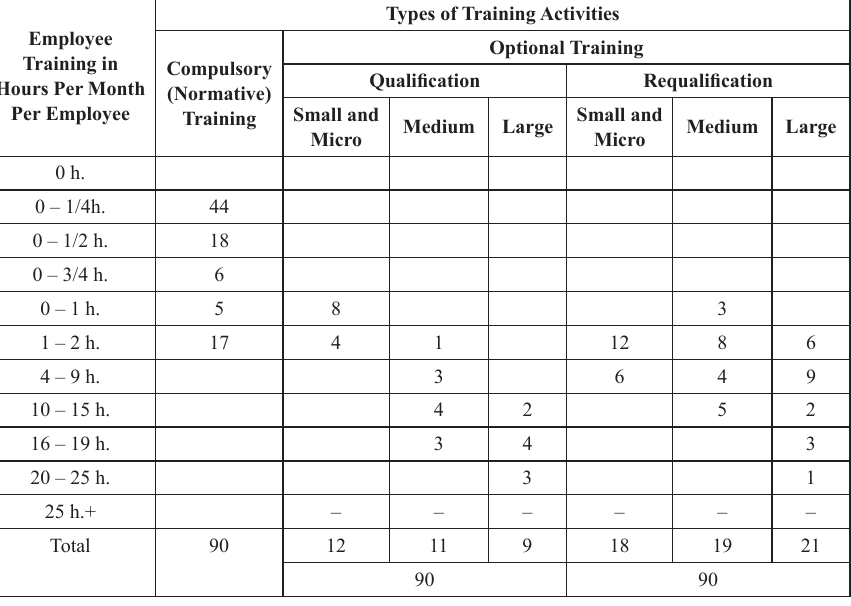
Table 1. Types of training activities in on-the-job